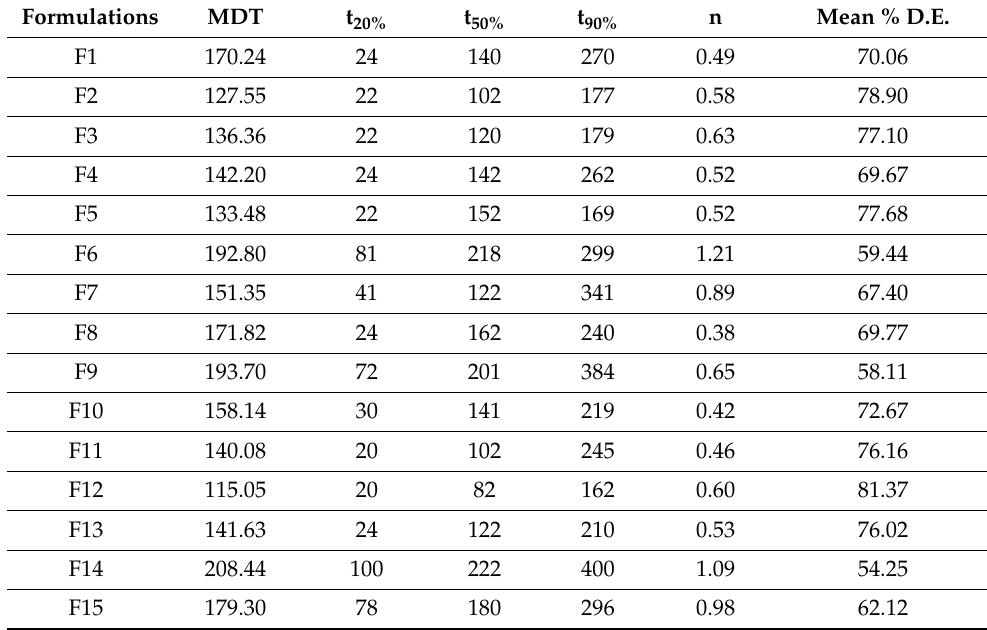
Table 2. Kinetic release properties of the developed